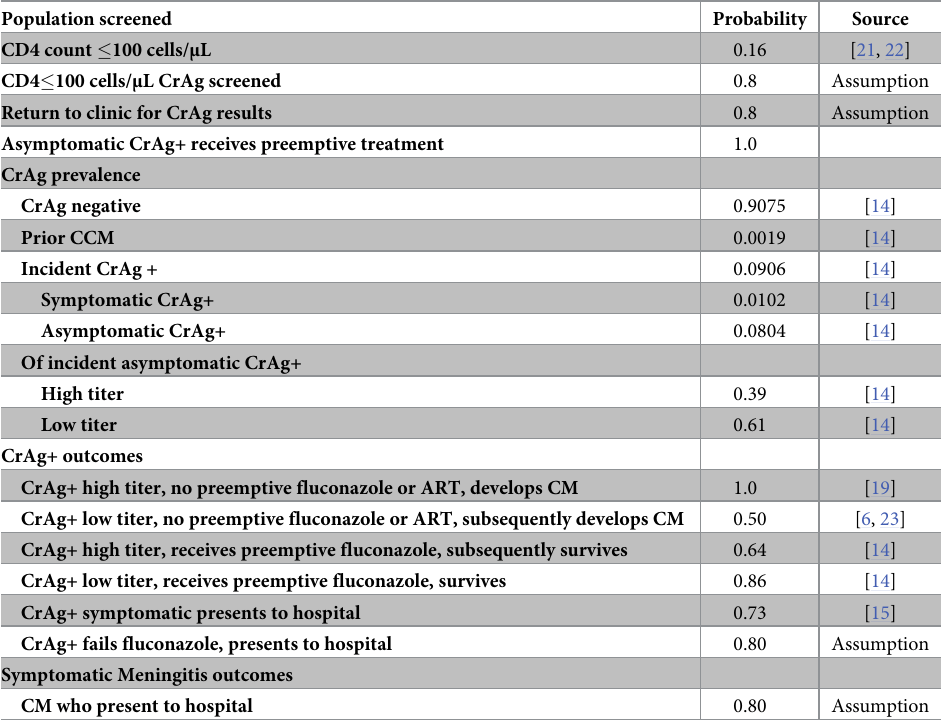
Table 1. Description of HIV-infected population screened in CD4 testing and reflexive lab screening model. Population